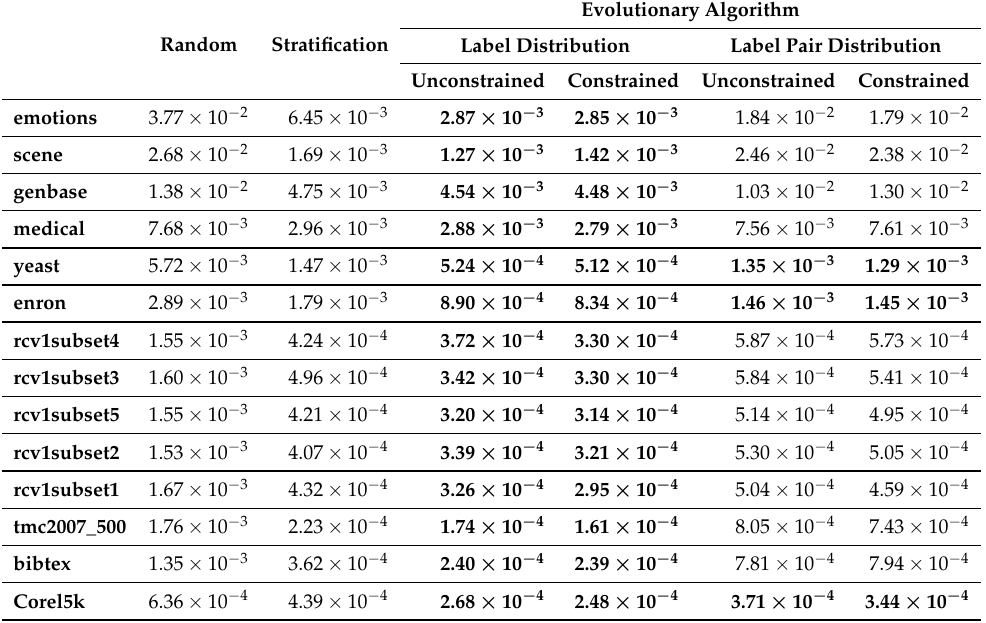
Table 3. Label Distribution of different splitting algorithms. The Stratification method is considered as the baseline. In bold the results that are better than the Stratification method. In all cases, the evolutionary algorithm that uses LD as fitness function obtains the best results. This does not happen when the LPD is used as fitness function.